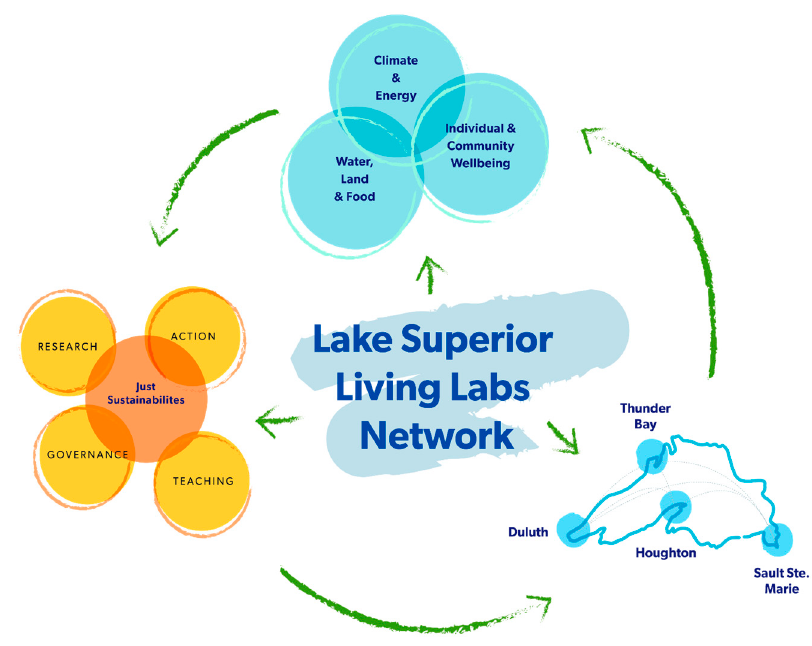
Figure 1. The Lake Superior Living Labs Network Orienting Diagram.